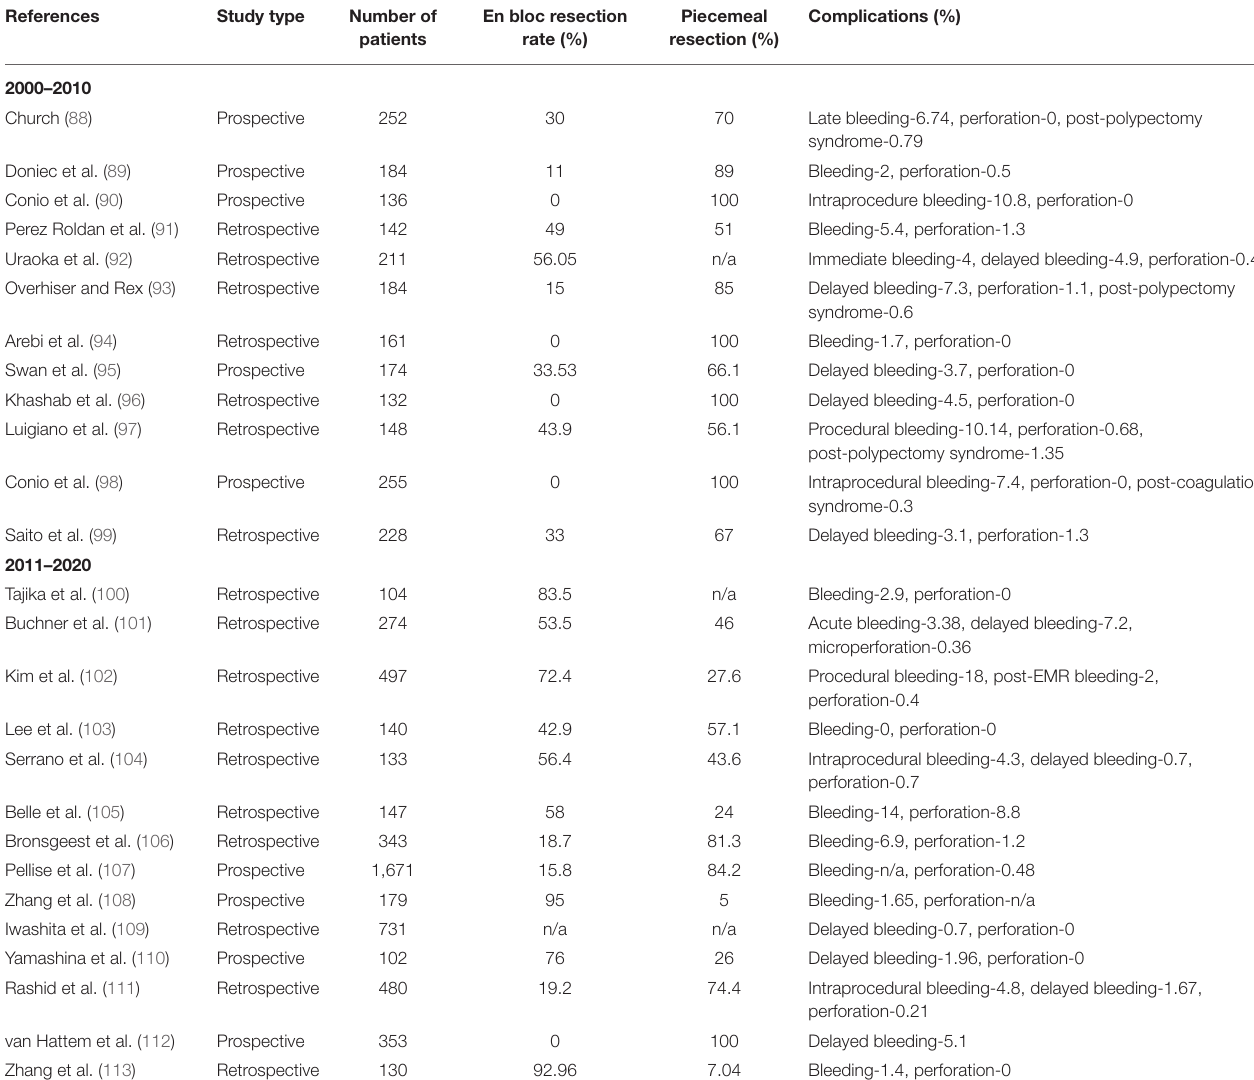
TABLE 1 | Endoscopic mucosal resection (EMR) for colon polyp studies with more than 100